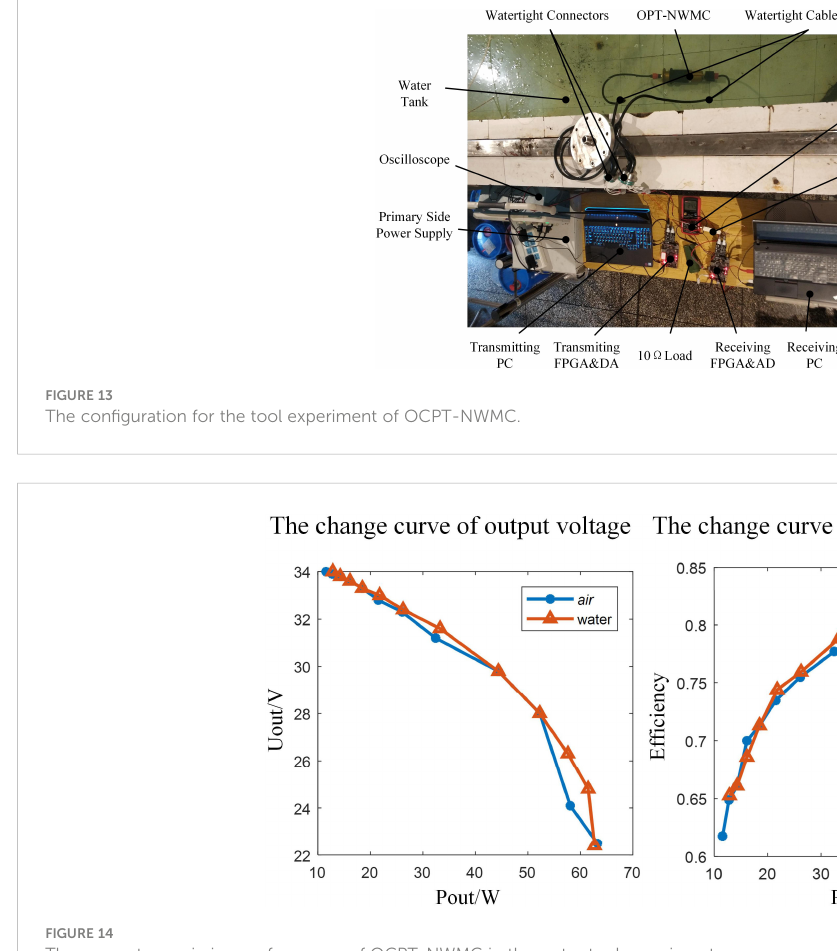
Figure 15A. It can be seen that the bandwidth of the system can reach about 18MHz. Limited by the test conditions, the bit error rate of the system was not be measured. More accurate system performance results can be obtained by analyzing the actual signal received and processed by the optical receiver. In order to test the transceiver performance, the transmitter continuously sends a string of “ non-